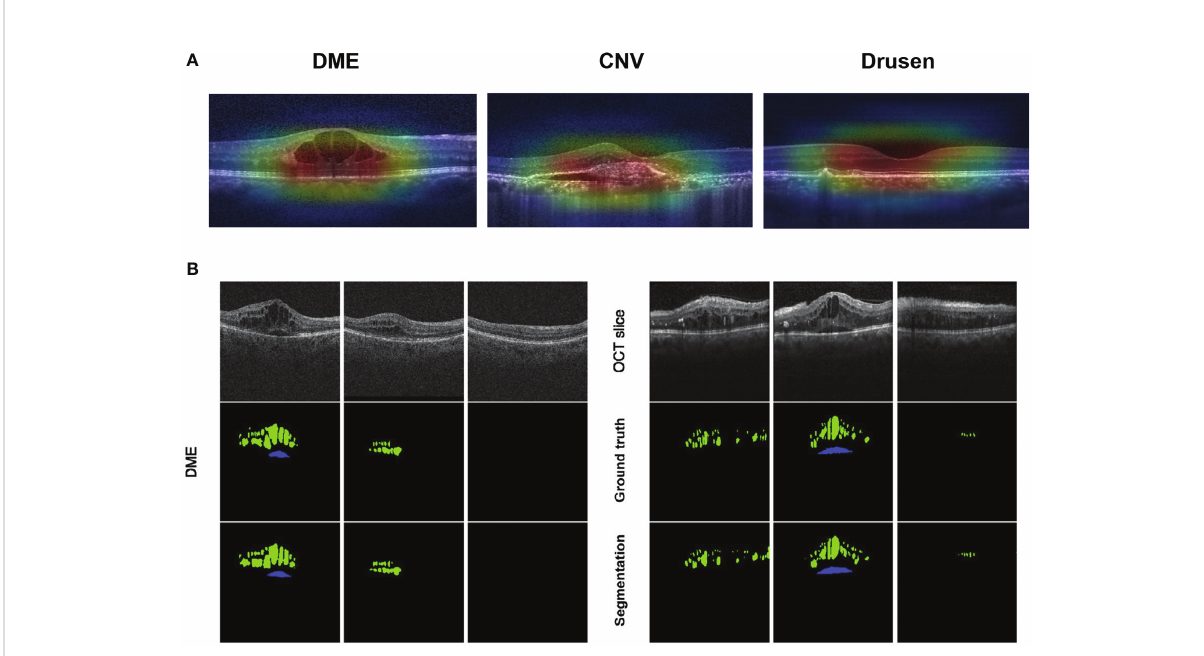
FIGURE 3 Visualization features generated automatically from optical coherence tomography (OCT). (A) Feature areas of pathology in diabetic macular edema (DME), choroidal neovascularization, and drusen are highlighted, superimposed on the input image to show the areas that the AI model considered as vital in a diagnosis. (B) Segmentation fi ndings of DME on OCT scans acquired with Cirrus (left) or Spectralis (right) devices: the upper row shows OCT raw slices; the middle row shows manual labels by certi fi ed graders considered as ground truth; the lower row shows automated results segmented by AI. (IRF, intraretinal cystoid fl uid in green; SRF, subretinal fl uid in blue) [Adapted from Schlegl et al., 2018